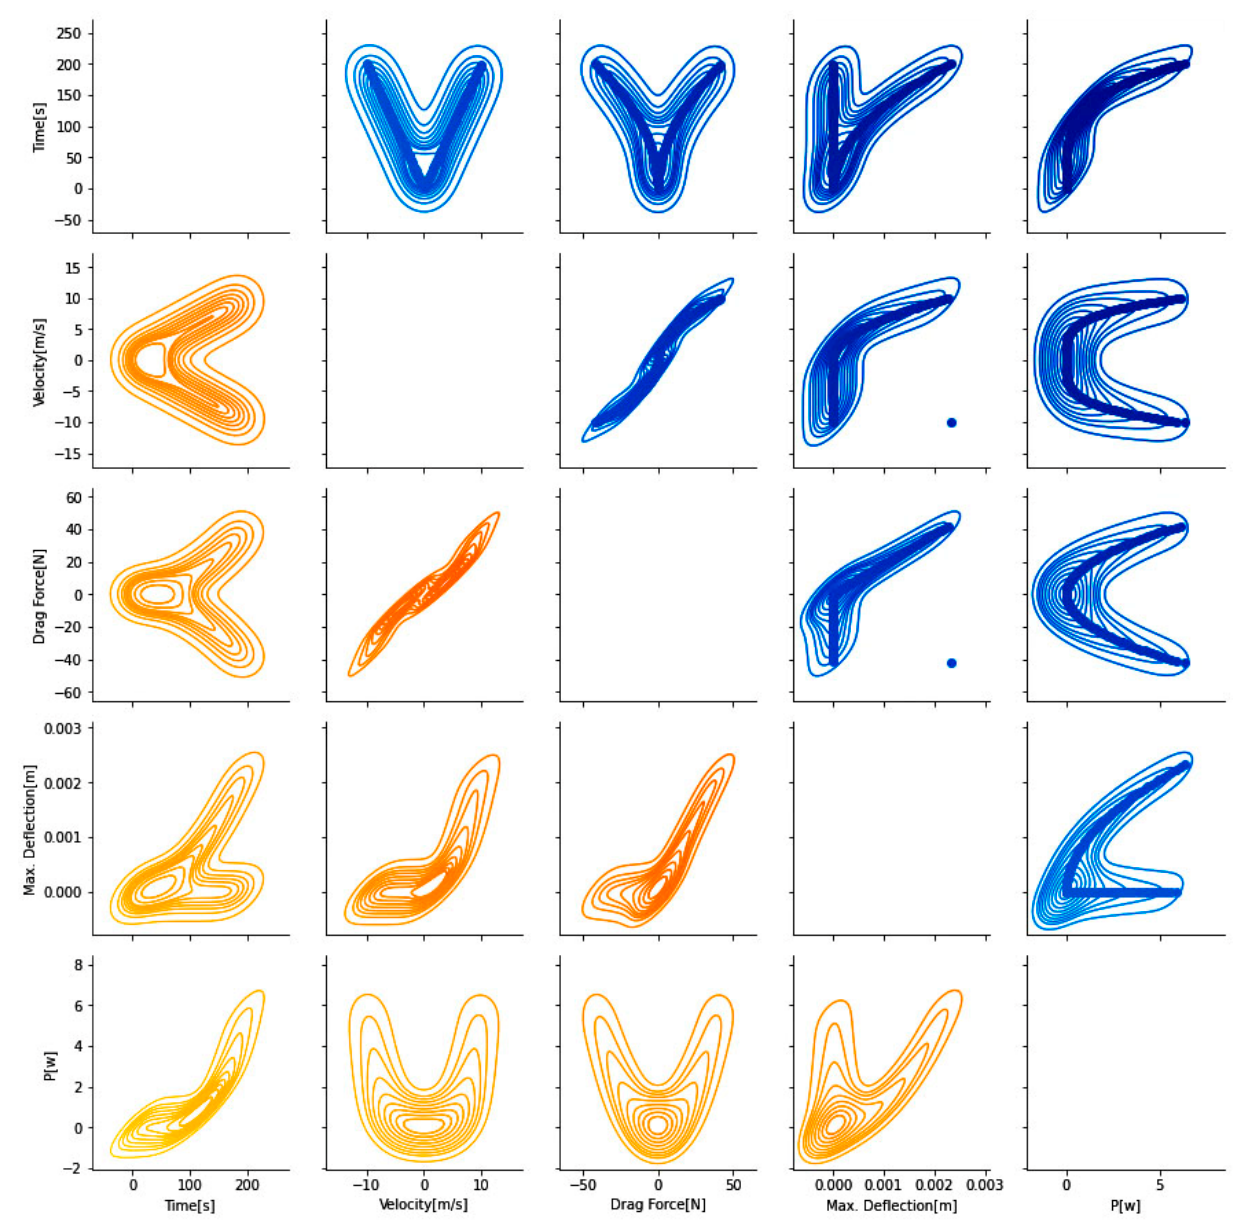
Figure 8. The overall figures of different parameter correlations. Table 3. Statistical descriptions of the numerical